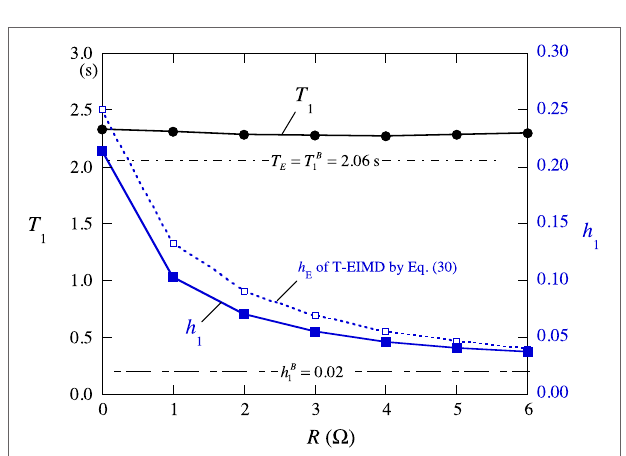
story drift angle, { β j }, to the prescribed target value, f (cid:22) β